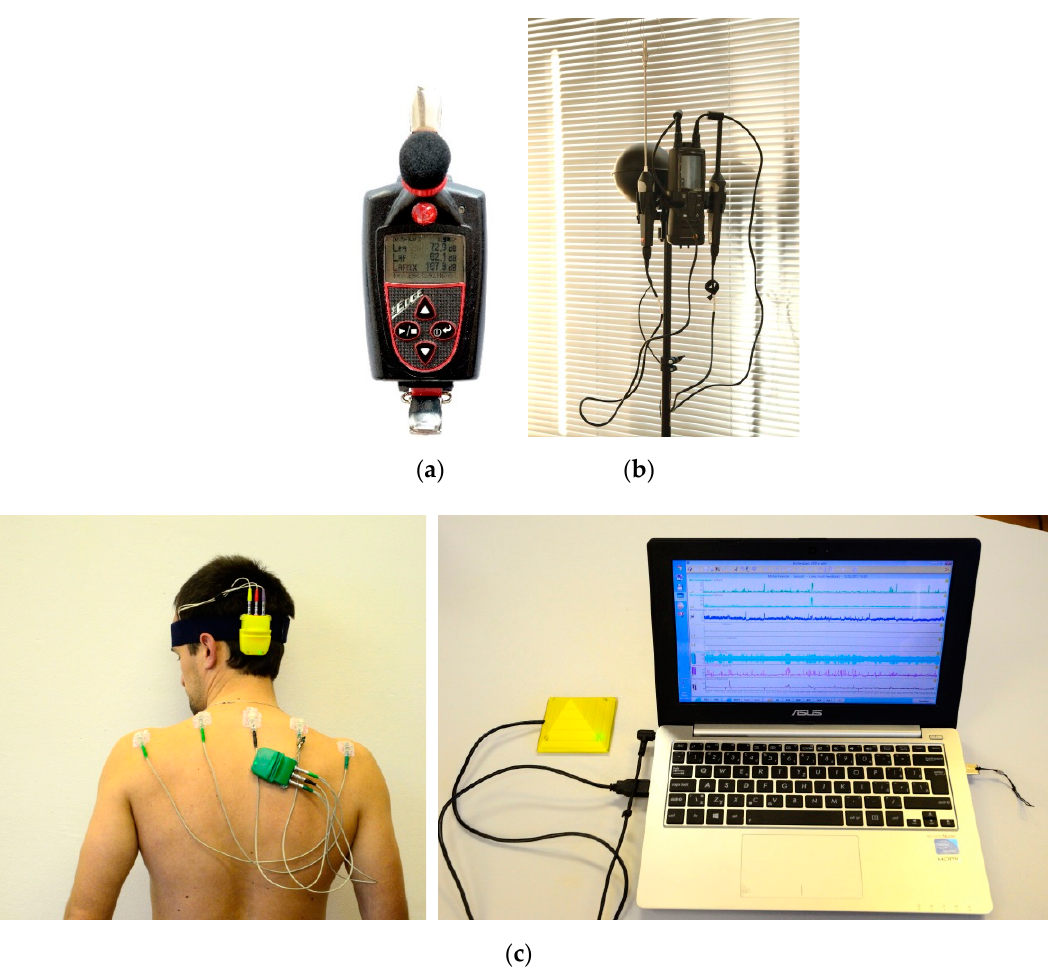
Figure 2. Measurement devices: ( a ) Quest Technologies, model EDGE eg3; ( b ) Testo 480; ( c ) Biofeed- back 2000 x-pert.